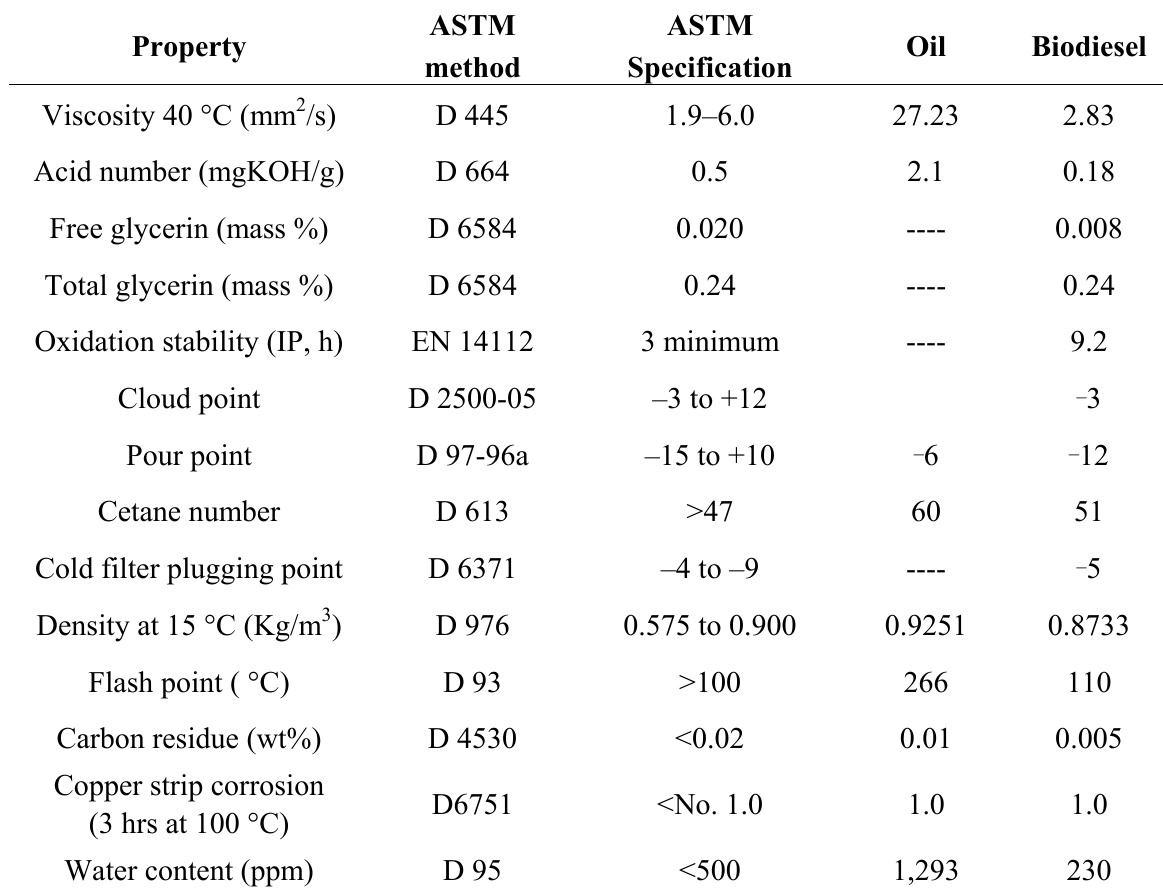
Table 3. Physical properties of coconut